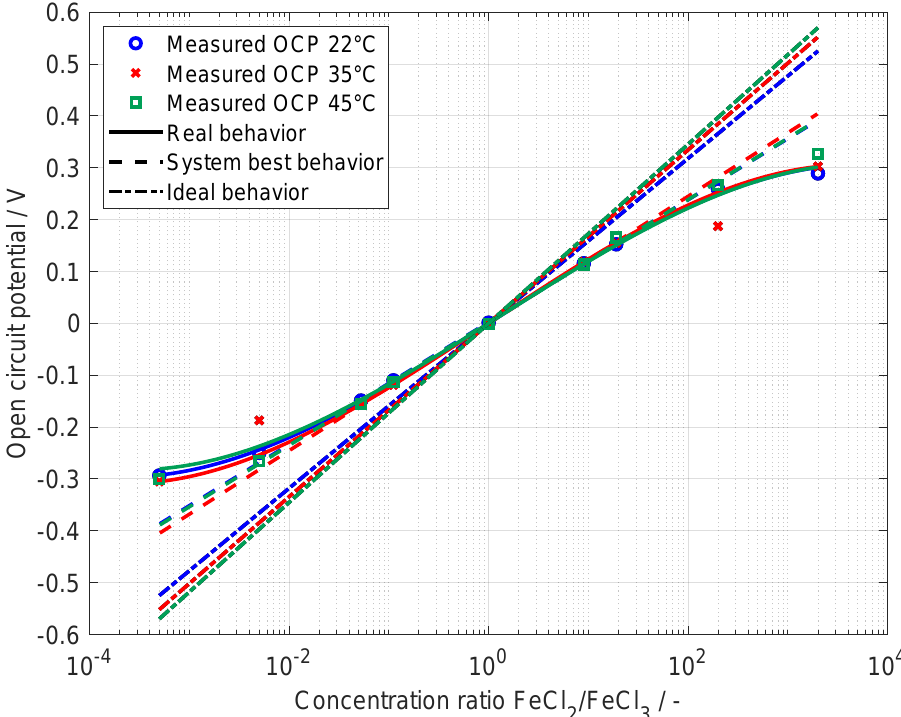
Figure 4. Measured open circuit potentials with the carbon fiber felt electrodes at different concentra- tion ratios of FeCl 2 /FeCl 3 and temperatures.